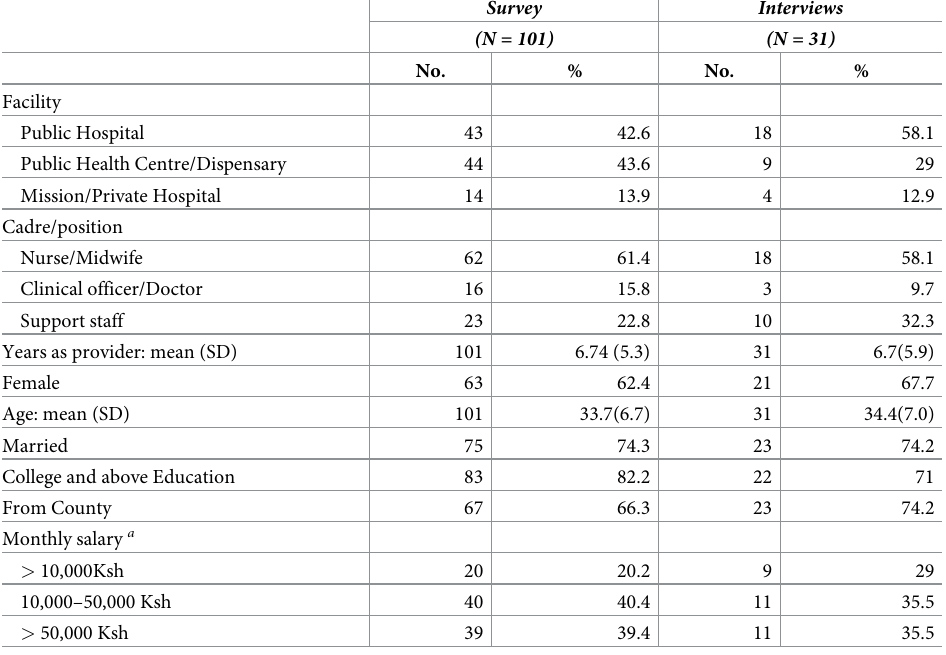
Table 1. Participant